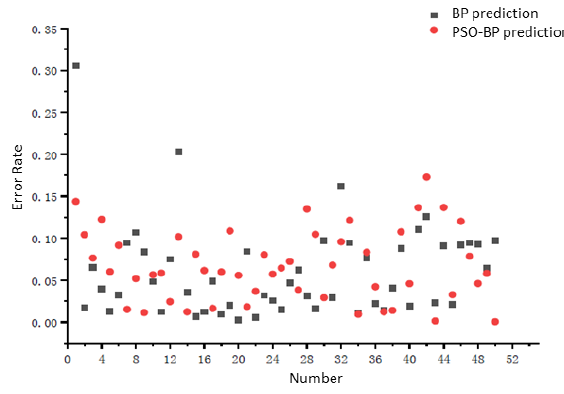
Table 5 . Error statistics on test